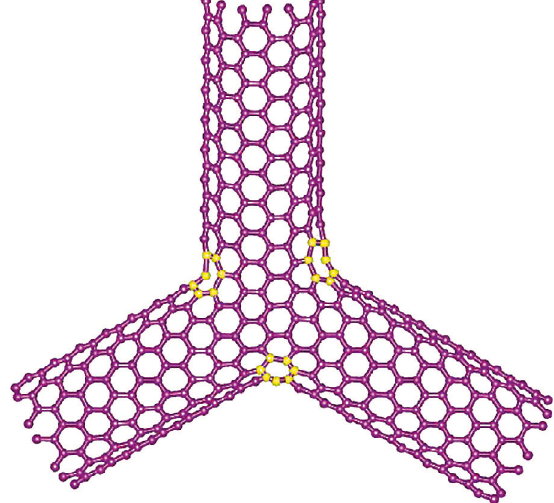
Figure 4: A variant of Y-junction Y 3